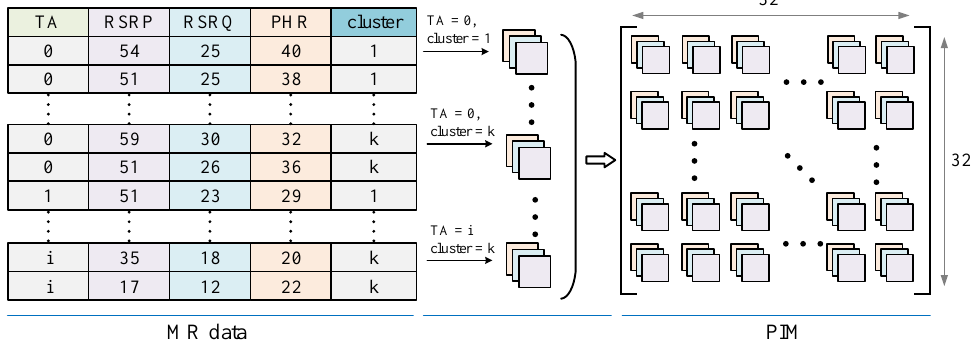
Figure 3. The sampling process of